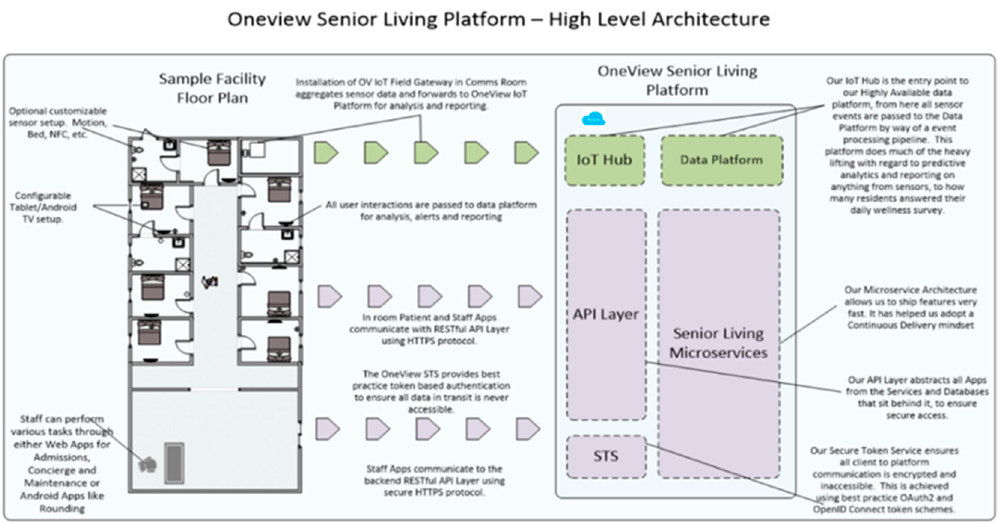
Figure 7. Technical architecture and security.